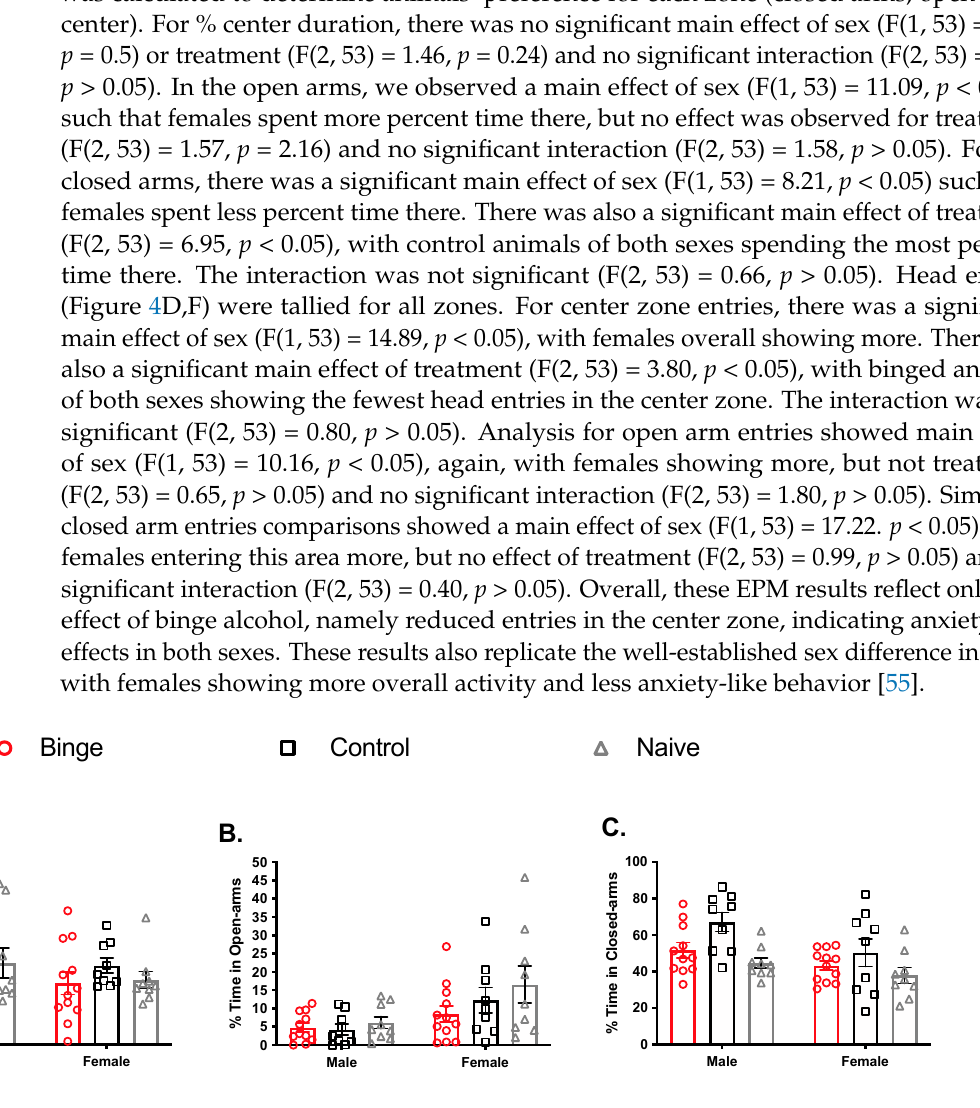
Figure 4. Effect of repeated binge exposure on anxiety-like behavior in males and females. Although there were no significant differences in % time in the center ( A ), binged animals of both sexes made the fewest head entries into the center ( D ). Females spent more % time ( B ) and made more head entries into the open arms ( E ), but there were no effects of binge. For the closed arms, males spent more time there compared to females ( C ). Females made more head entries into the closed arms ( F ) compared to males. Bars represent ± SEM from 9–12 subjects per group.